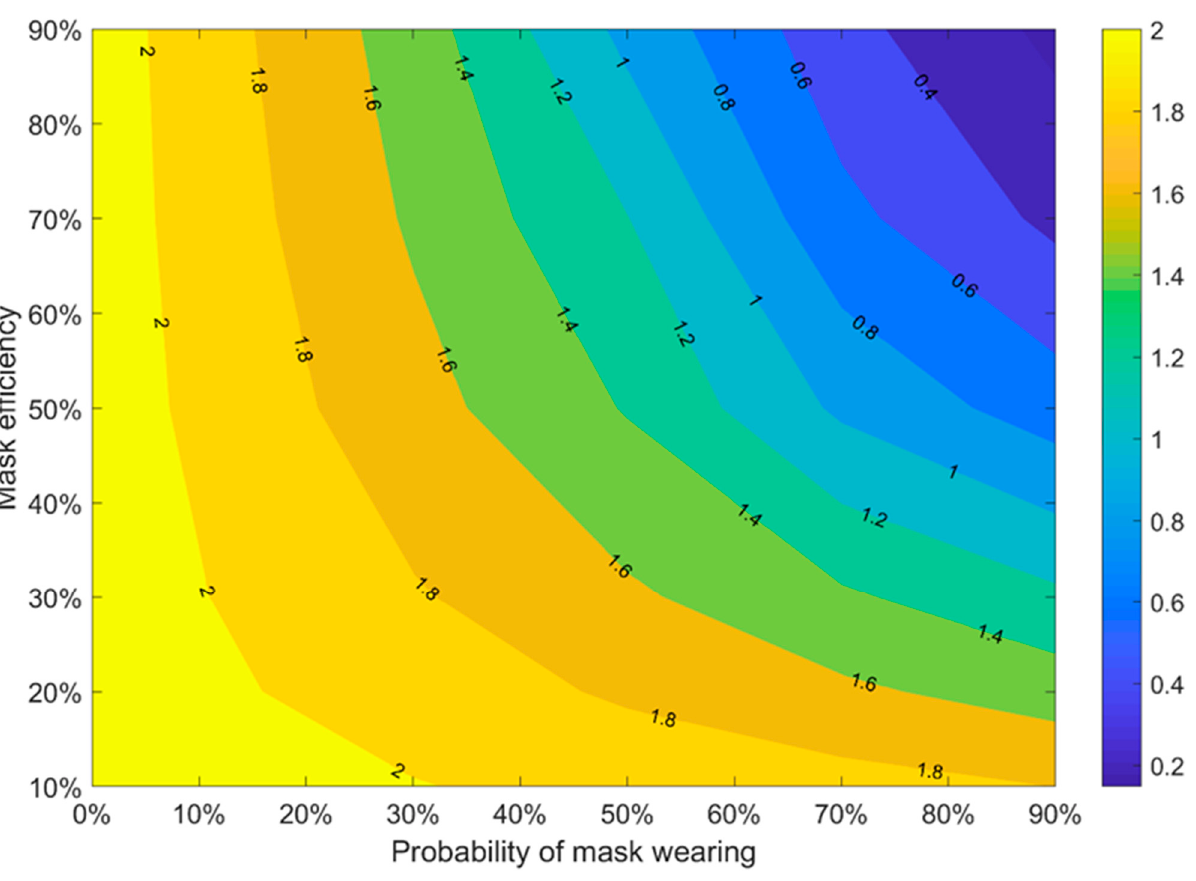
Figure 3. Median of effective reproduction number with the only presence of 100% case isolation (without using contact tracing and people gathering restrictions). Twenty initial symptomatic cases, 20 initial asymptomatic cases, initial R 0 = 2.5, R a = 1.875, all people wear masks, and the mask hinders spreading and protects from getting infected with different mask efficiency, 4 days of mean delay, 40% transmission before symptoms.